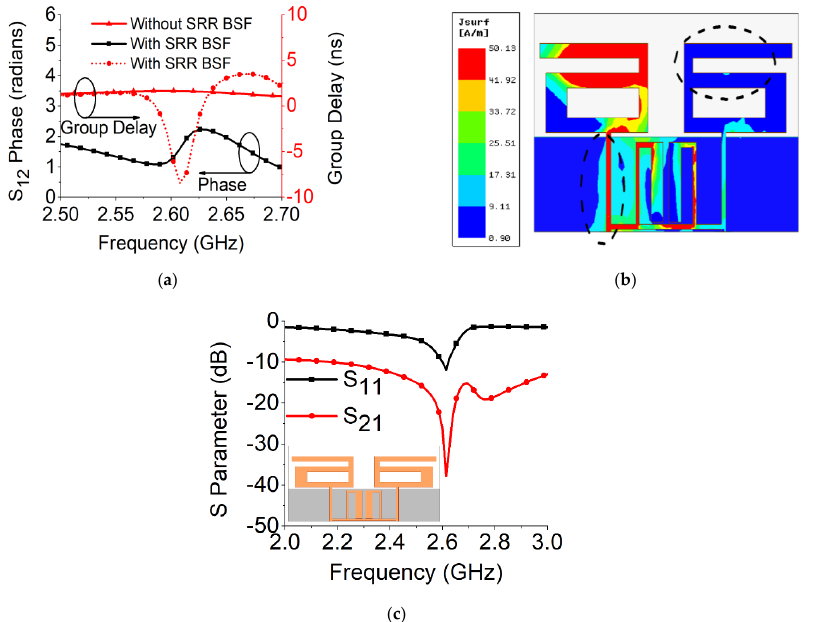
Figure 5. MIMO antenna with SRR-based BSF: ( a ) group delay and phase response; ( b ) current distribution; ( c ) S